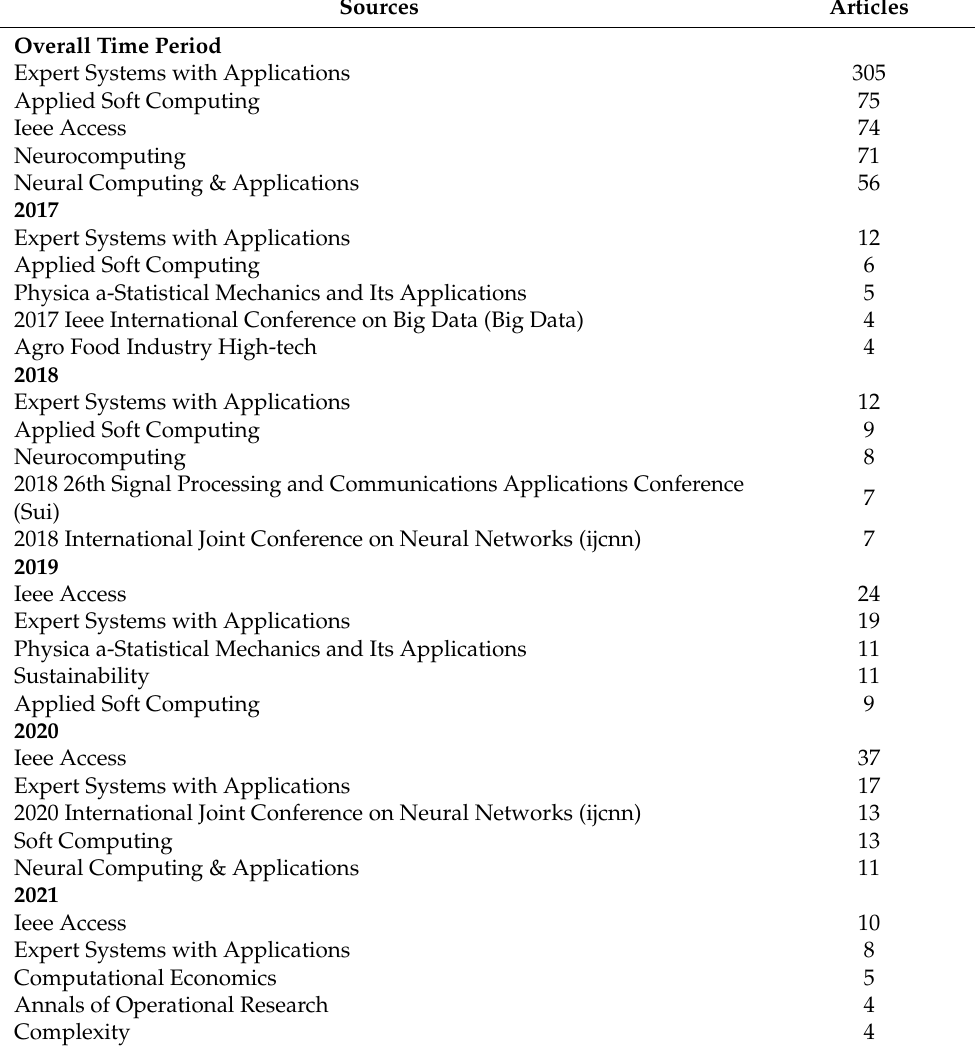
Table 10. Top journals, overall period, and per